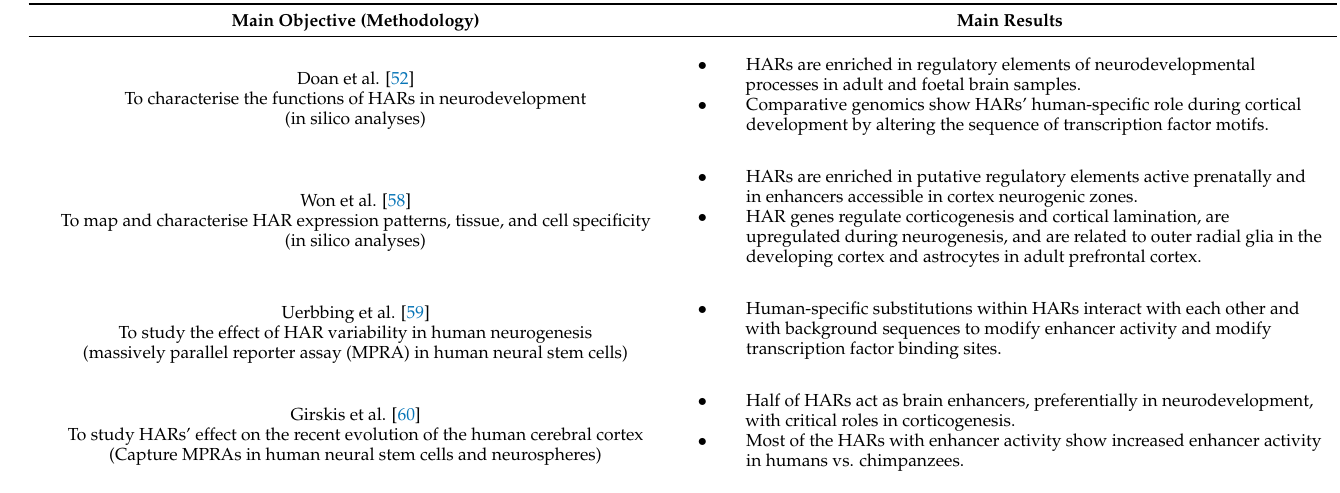
Table 1. Summary of the main findings of whole-genome-based studies assessing the role of HARs in neurodevelopment.